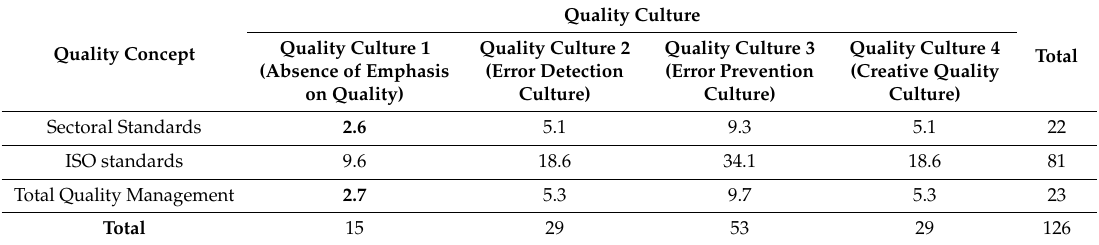
Table A1. Cross-tabulation of quality culture and quality concept (expected counts).